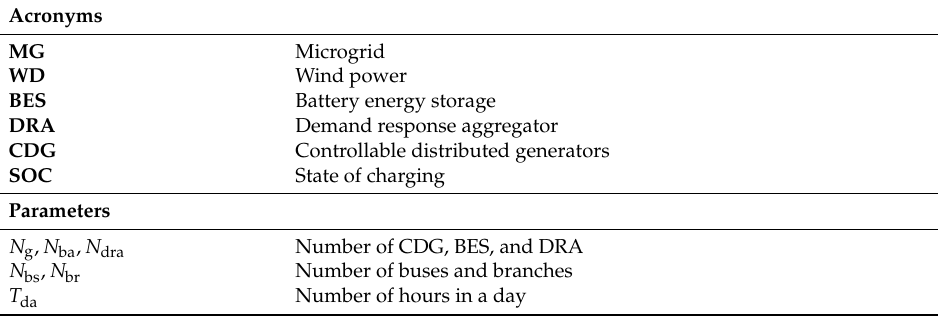
Table A1. Notations for the model